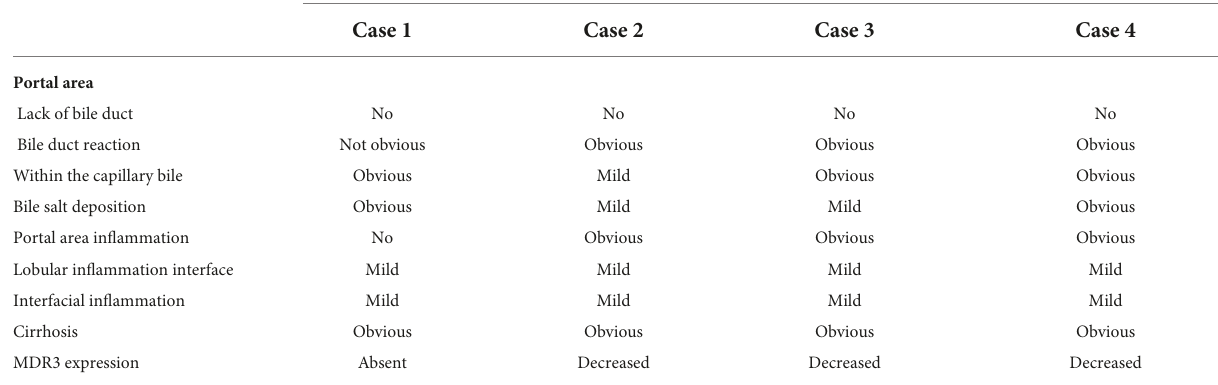
TABLE 2 Summary of histologic